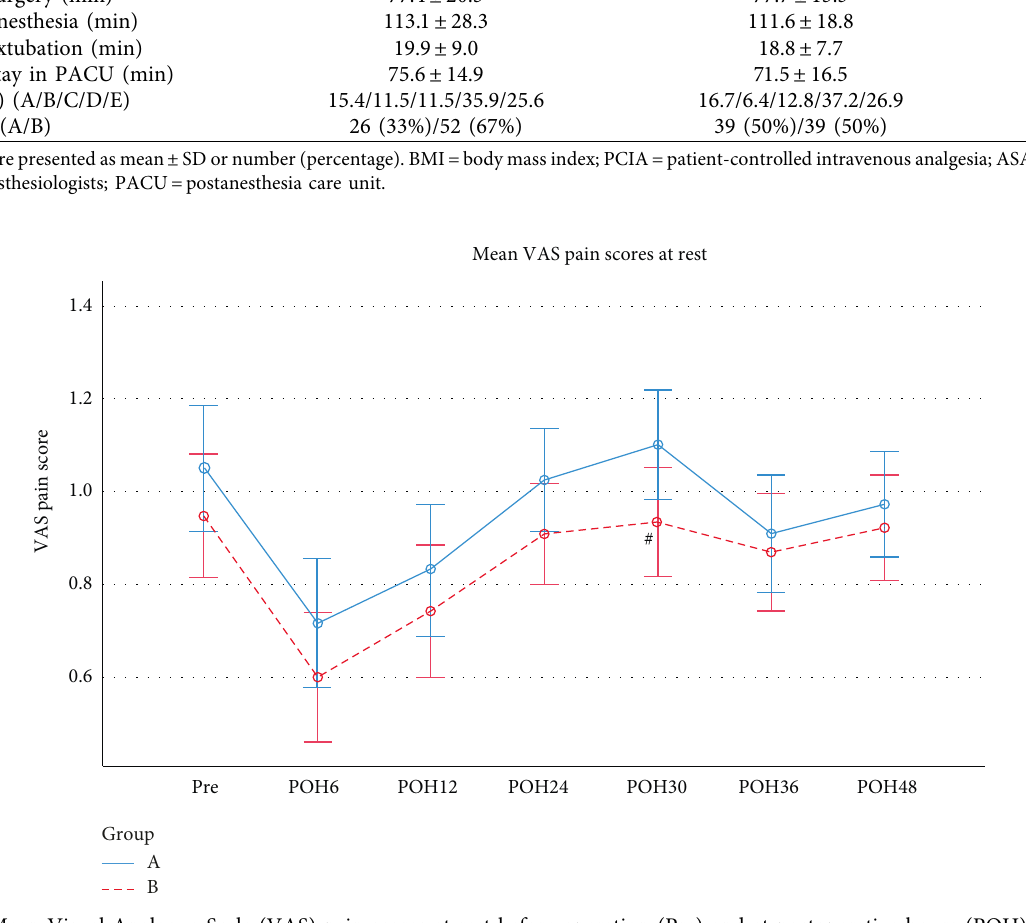
Figure 1: Mean Visual Analogue Scale (VAS) pain scores at rest before operation (Pre) and at postoperative hours (POH), # P < 0 .